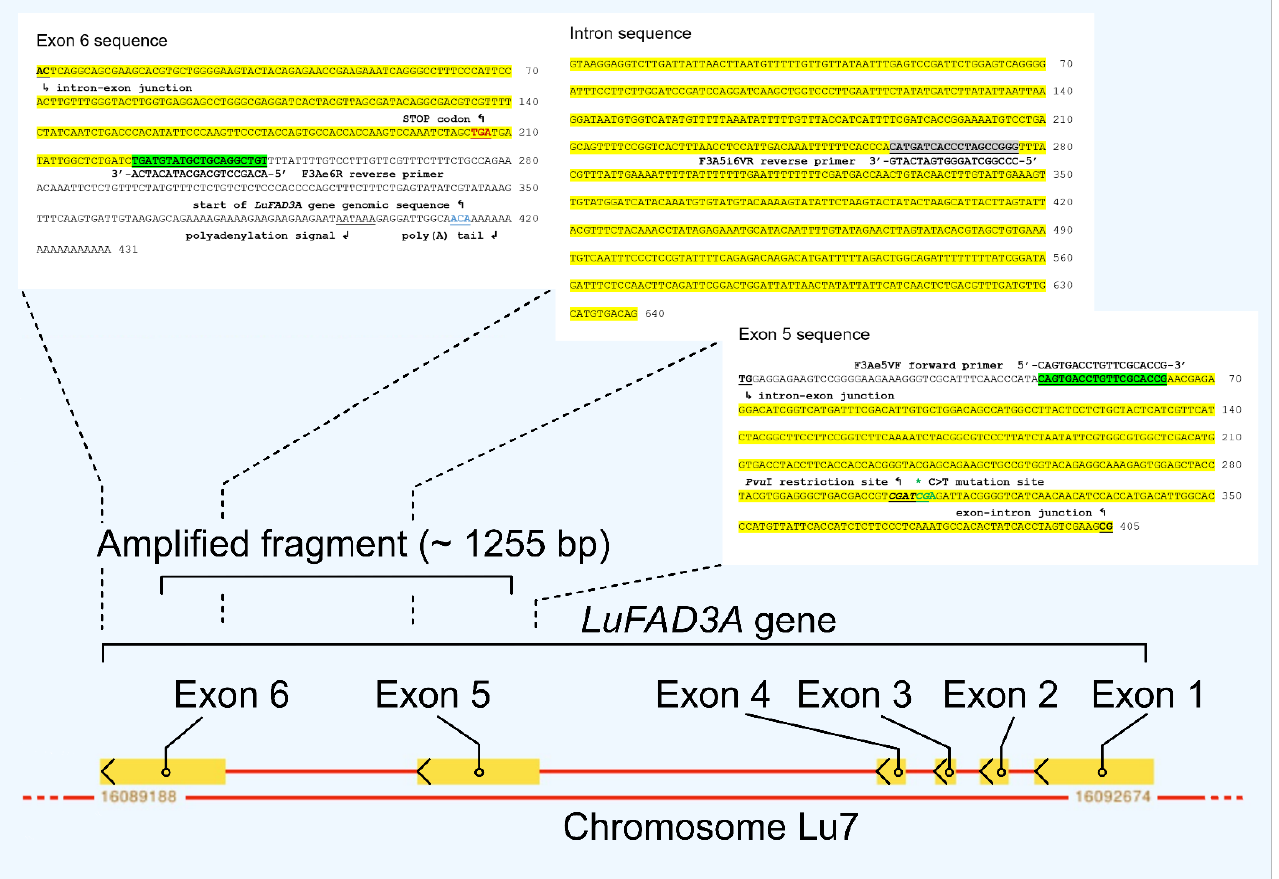
Figure 2. An overview of the presented CAPS markers concerning the structure and sequence of the flax LuFAD3A gene. The sequences shown for exon 5 and exon 6 of the LuFAD3A gene are based on the Vrinten et al.’s [8] mRNA sequence, and the sequence of intron was deduced from the genomic sequence presented by Wang et al. [13]. The sequence of the amplified gene fragment is marked yellow; the sequences complementary to primers are marked green for the pair of primers described in Materials and Methods (F3Ae5VF forward primer is the original Vrinten et al ’s [8] primer and the F3Ae6R reverse primer is a newly designed one), and marked grey for the Vrinten et al. ’ s [8] original F3A5i6VR reverse primer. Additionally, the Pvu I restriction site and the C>T mutation site identified by Vrinten et al. [8] in exon 5 are indicated (green asterisk). It must be noted that the LuFAD3A gene is encoded on the opposite strand when looking at the genomic sequence of the flax chromosome Lu7. Therefore, the start of the LuFAD3A gene genomic sequence from exon 6 [13] is also shown (underlined blue).